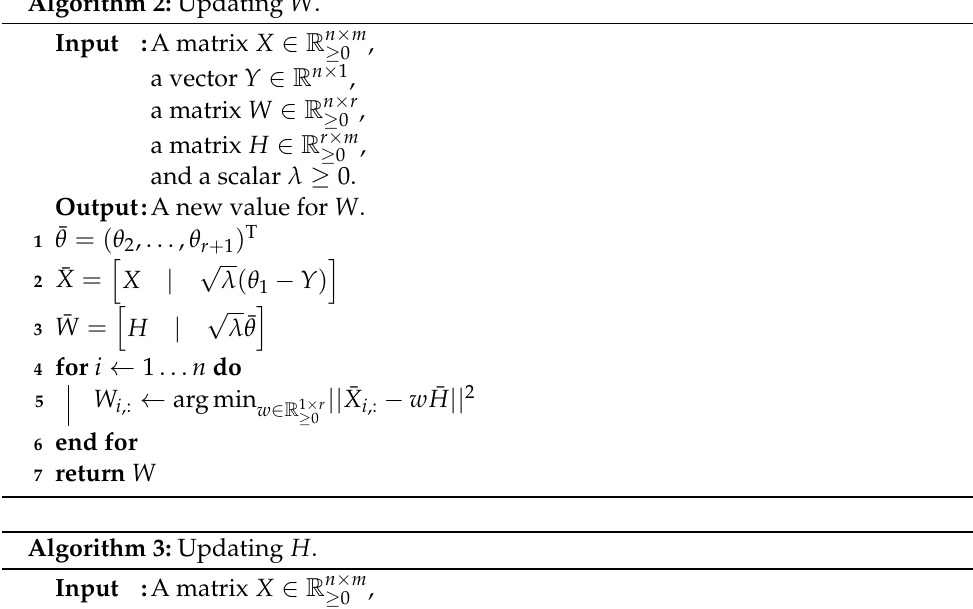
Algorithm 3: Updating H .